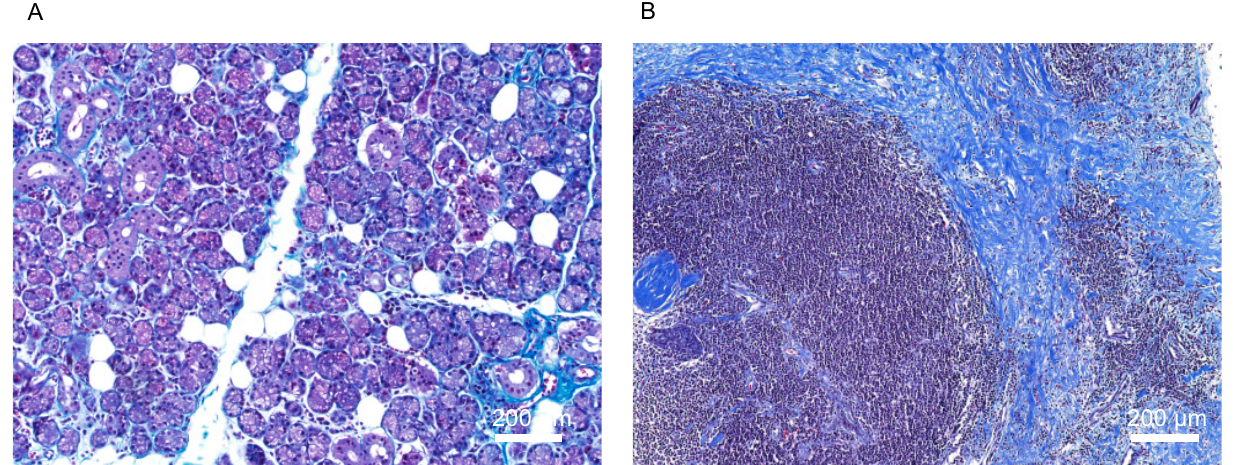
Figure 1. Infiltration of lymphocytes and tissue fibrosis in IgG4-RD. Masson trichrome staining in submandibular glands from a healthy control ( A ) and a patient with IgG4-RD ( B ). Massive infiltration of lymphocytes and fibrosis are seen in IgG4-RD, while normal glandular structures are observed in healthy control.